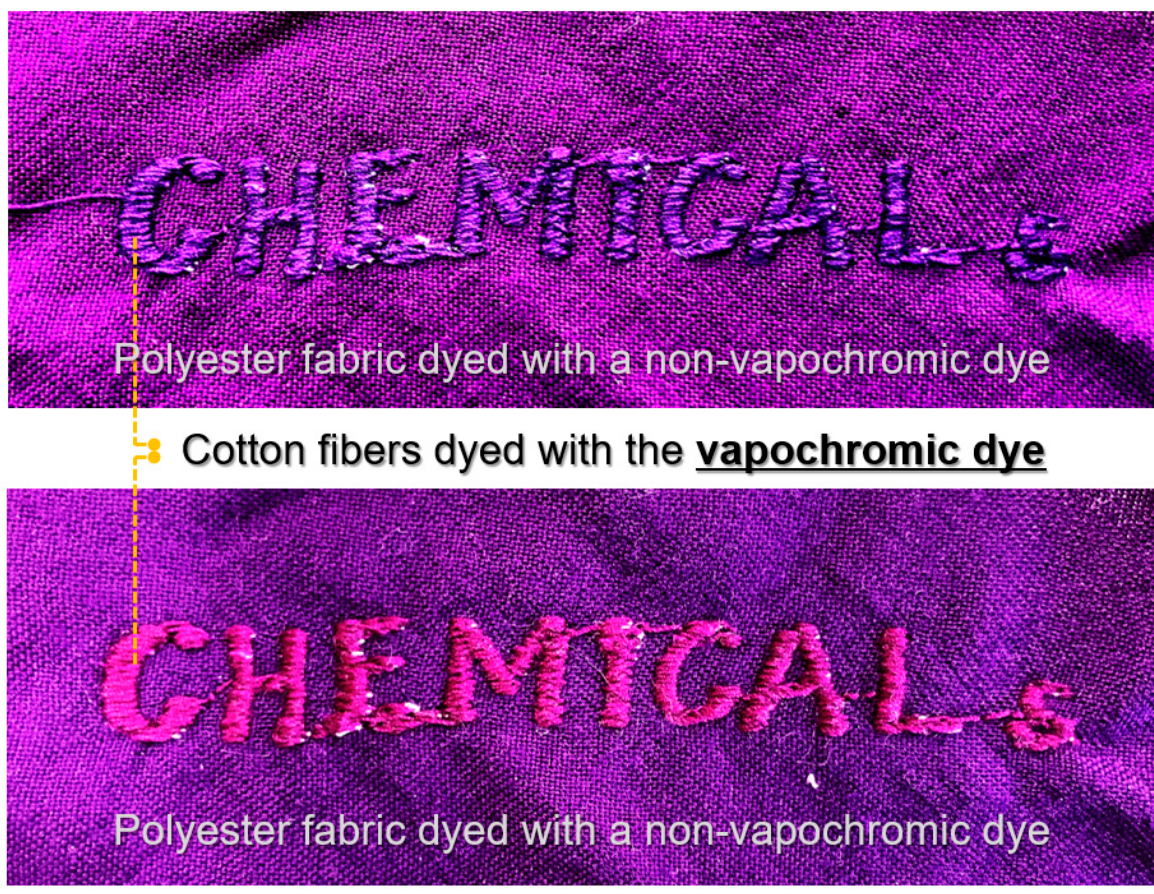
DM ( c ) Figure 5. ( a ) Rate of color change in cellulosic fabrics dyed with DMx and DM upon exposure to DMAc, MeOH, and acetone. ( b ) Change in color spectra of dyed samples exposed to 300 ppm DMAc for 24 h. ( c ) Color coordination before and after exposure to 300 ppm DMAc. To visualize the performance of the textile-based vapor sensor, we dyed cotton fila- ment yarn with synthesized vapochromic dye (DM) and then embroidered it as the letter-